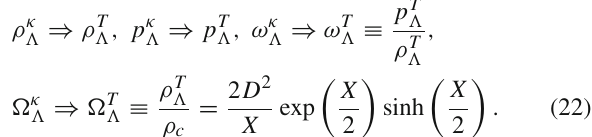
(cid:8) m = − 1 − 3 ω κ (cid:8) κ (cid:7) which states that (cid:7) CDM model, we have (cid:8) m